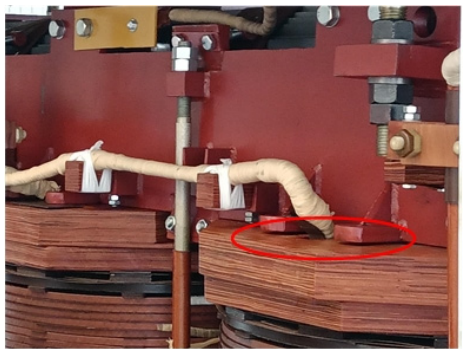
Figure 5. Diagram of transformer winding pad falling.